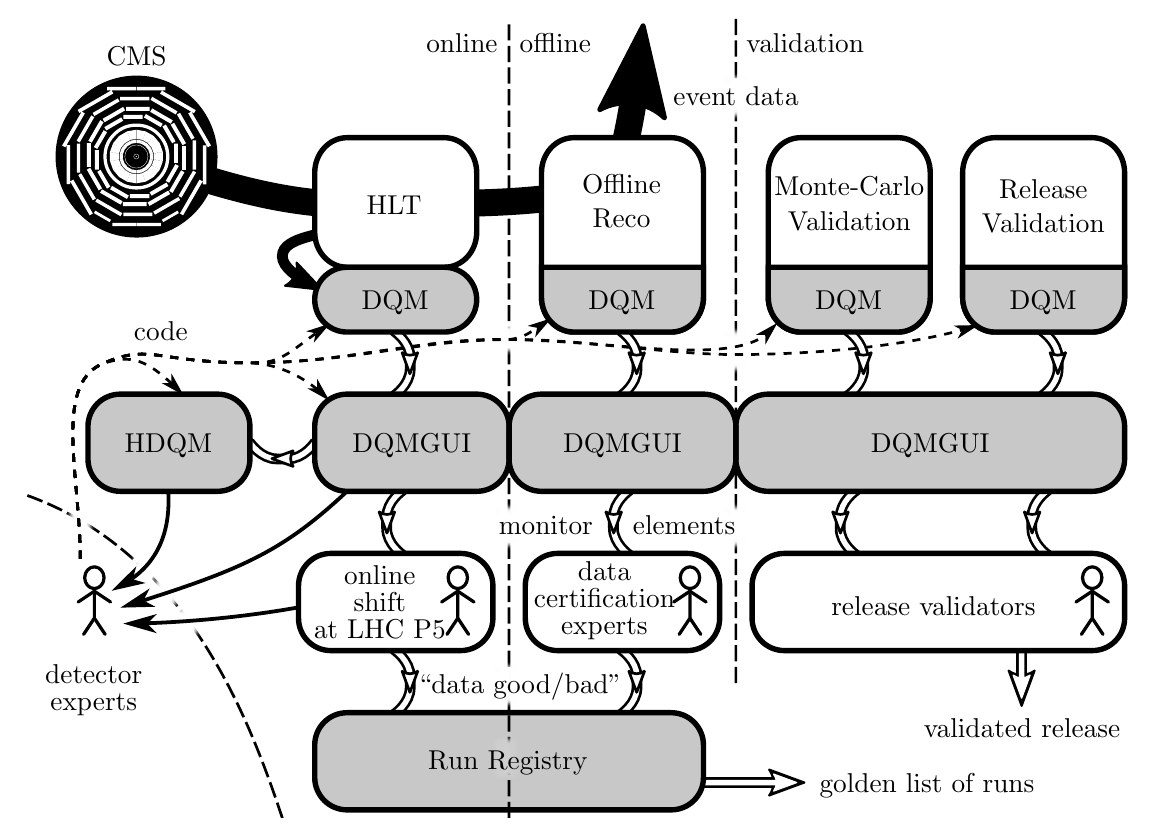
Figure 1. Schematic overview of the DQM